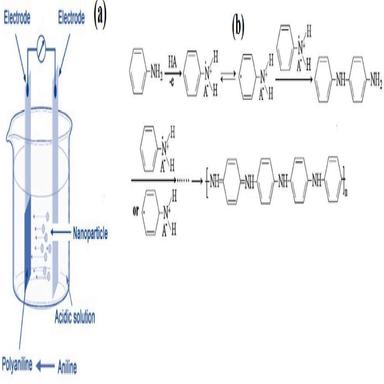
(a) Schematic illustration of electrochemical synthesis process. (b) Electrochemical formation mechanism of PANI.